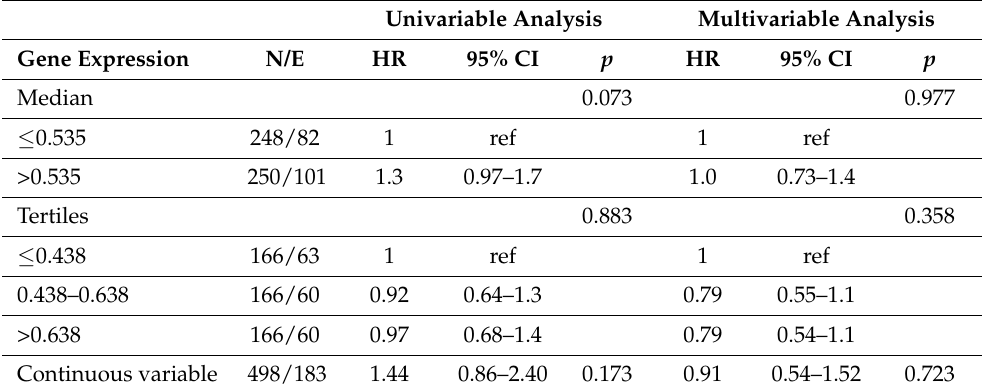
Table 9. Event Free Survival of 498 NB patients in relation to LOC730811 expression levels evaluated by the model.